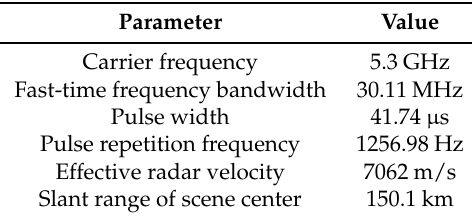
Table 1. Simulation parameters.